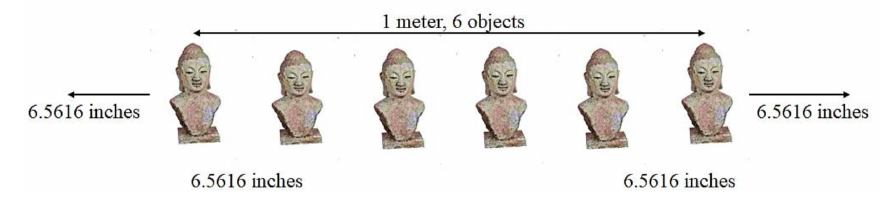
Figure 20. Doubling the number of objects within the same area (1 m, 6 objects).